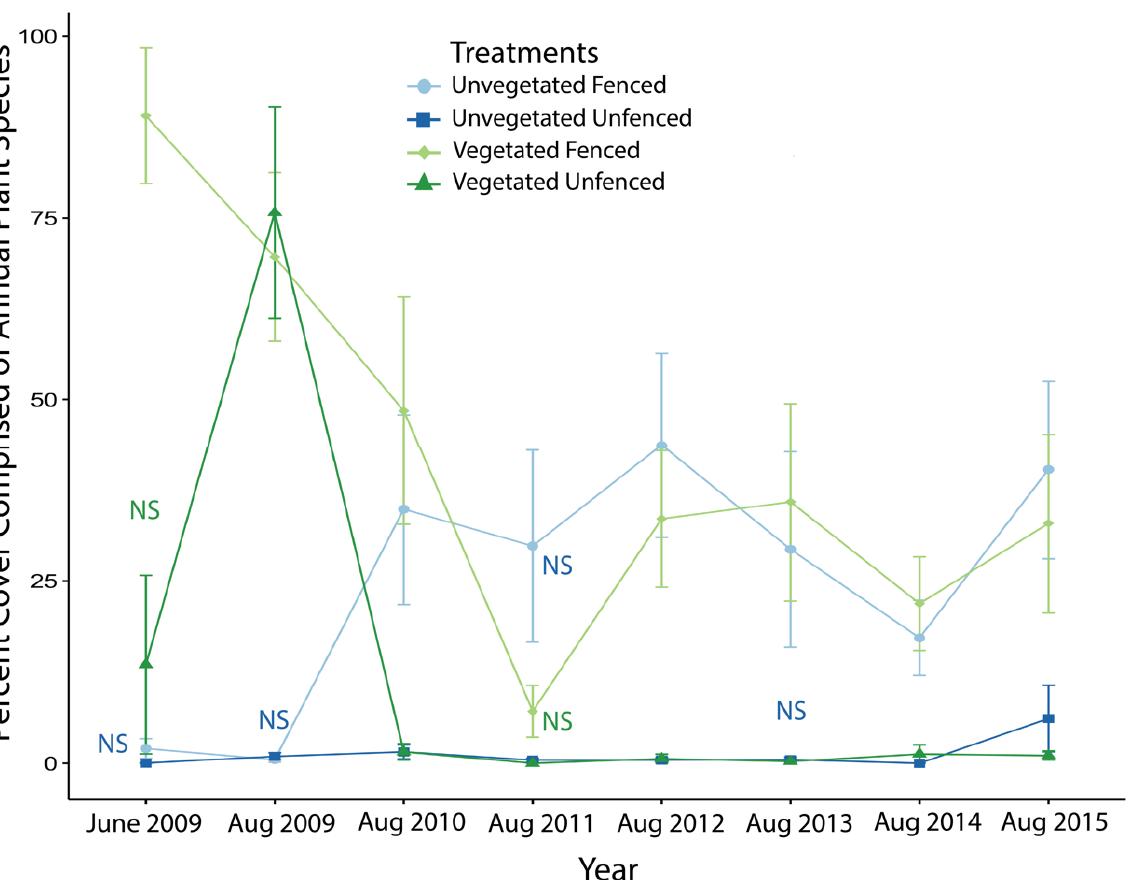
Figure 3. Percent cover of annual species through time in fenced (lighter colors) and unfenced (darker colors) plots of initially vegetated (green) and initially unvegetated (blue) modules. June 2009 data are included as a baseline; all other data presented were collected in August to reflect that year’s growing season. Labels of “NS” indicate a nonsignificant difference between control and exclosure treatments on that sampling date and color-coded to indicate initially vegetated state; on all other dates, differences were statistically significant. t -test statistics are reported in Table S2. Error bars are standard error.